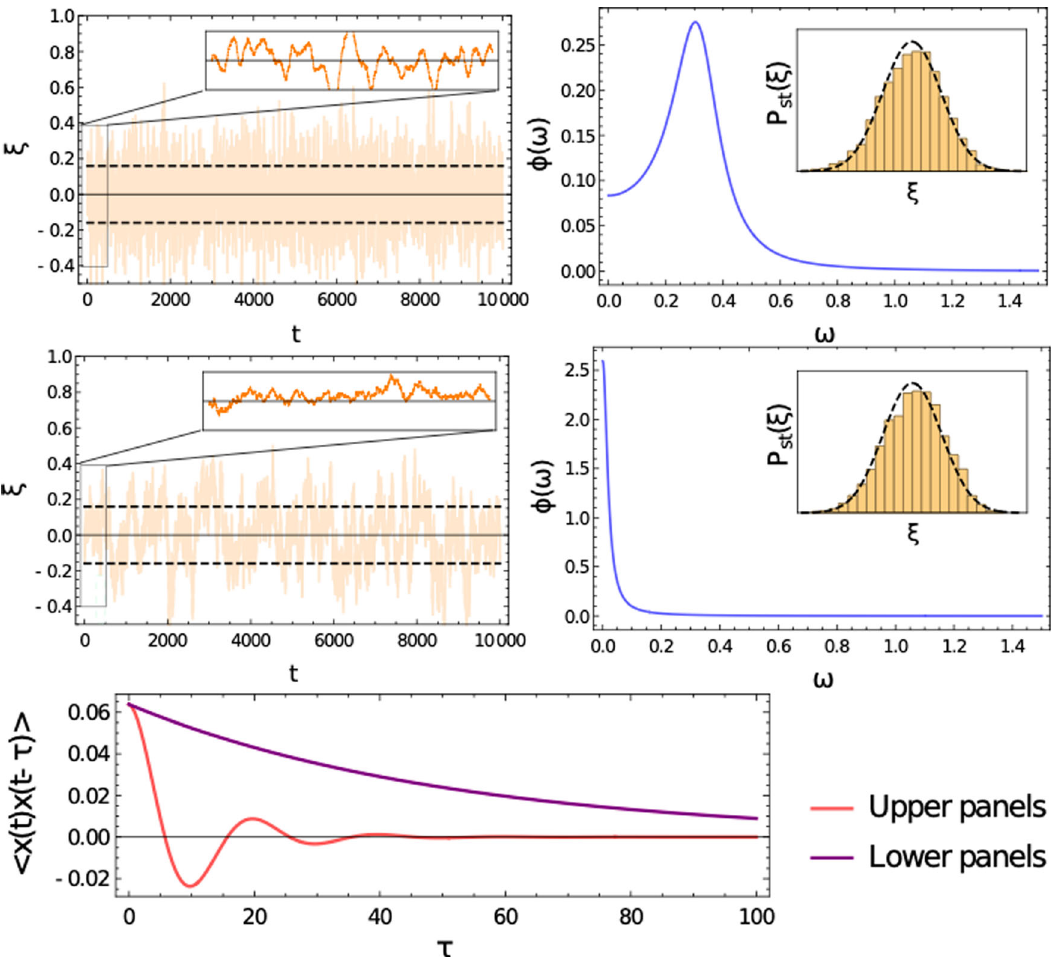
Fig. 7 Example time series and corresponding fl uctuation spectra for illustration. Left panels: Examples of stochastic trajectories with 0 means indicated by solid lines and the standard deviations indicated by dashed lines. Insets show the same trajectories over a smaller time-window. Right panels: Corresponding power-spectral densities of the trajectories in the left hand panels. Insets show histograms of the corresponding stochastic trajectories, overlaid by the theoretical stationary distribution (black dashed line). Bottom panel: The temporal autocorrelation of the stochastic trajectories in the left hand panels can be obtained as the Fourier transform of the corresponding power spectra in the right hand